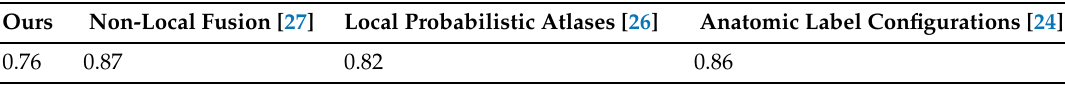
Table 6. Dice coefficients obtained by supervised techniques compared to our proposed method as evaluated within the MMWHS grand challenge